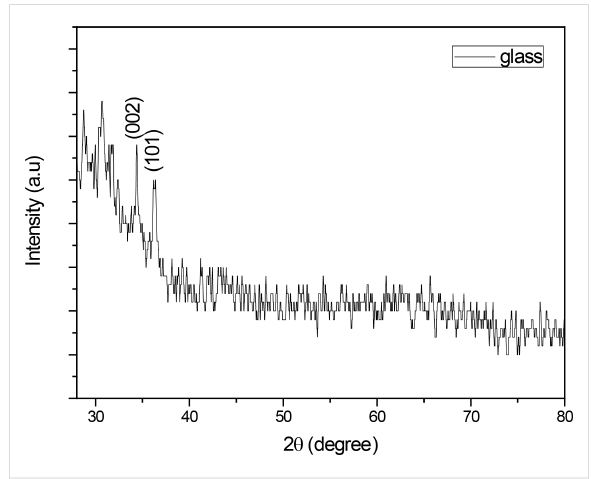
Figure 1: XRD pattern of nanostructured thin films on a glass sub-